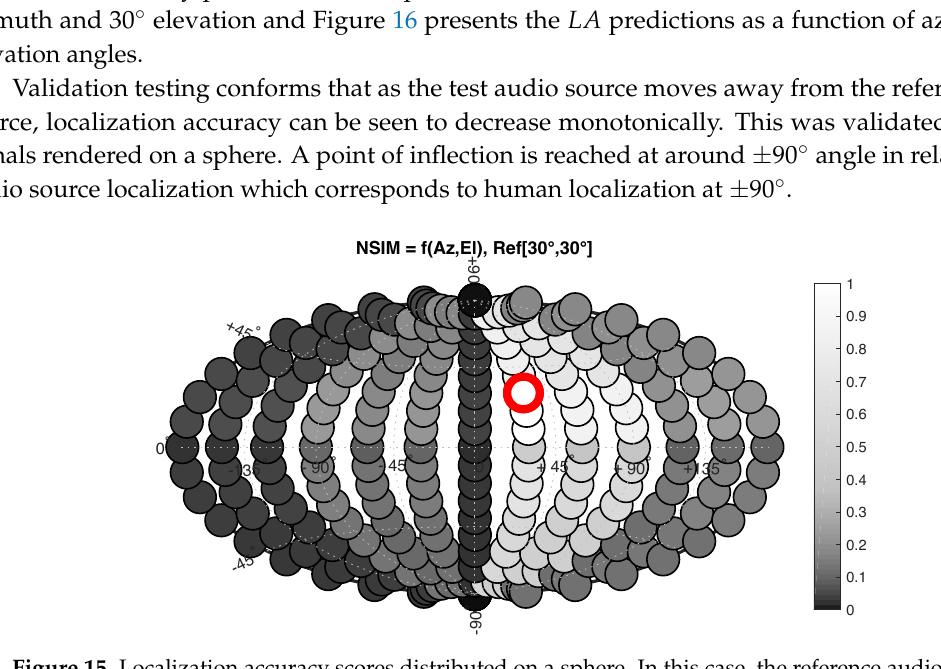
Figure 15. Localization accuracy scores distributed on a sphere. In this case, the reference audio source was localized at azimuth = 30 ◦ , elevation = 30 ◦ (the red circle represents the reference audio